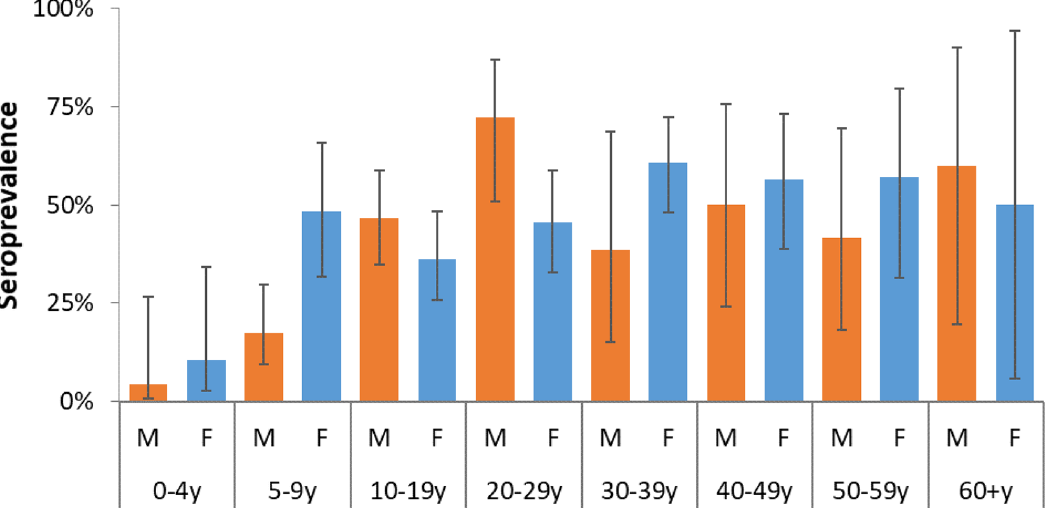
Figure 4. Weighted individual seropositivity of SARS-CoV-2 antibodies stratified by age-sex groups in Kibera urban informal settlement, Nairobi,